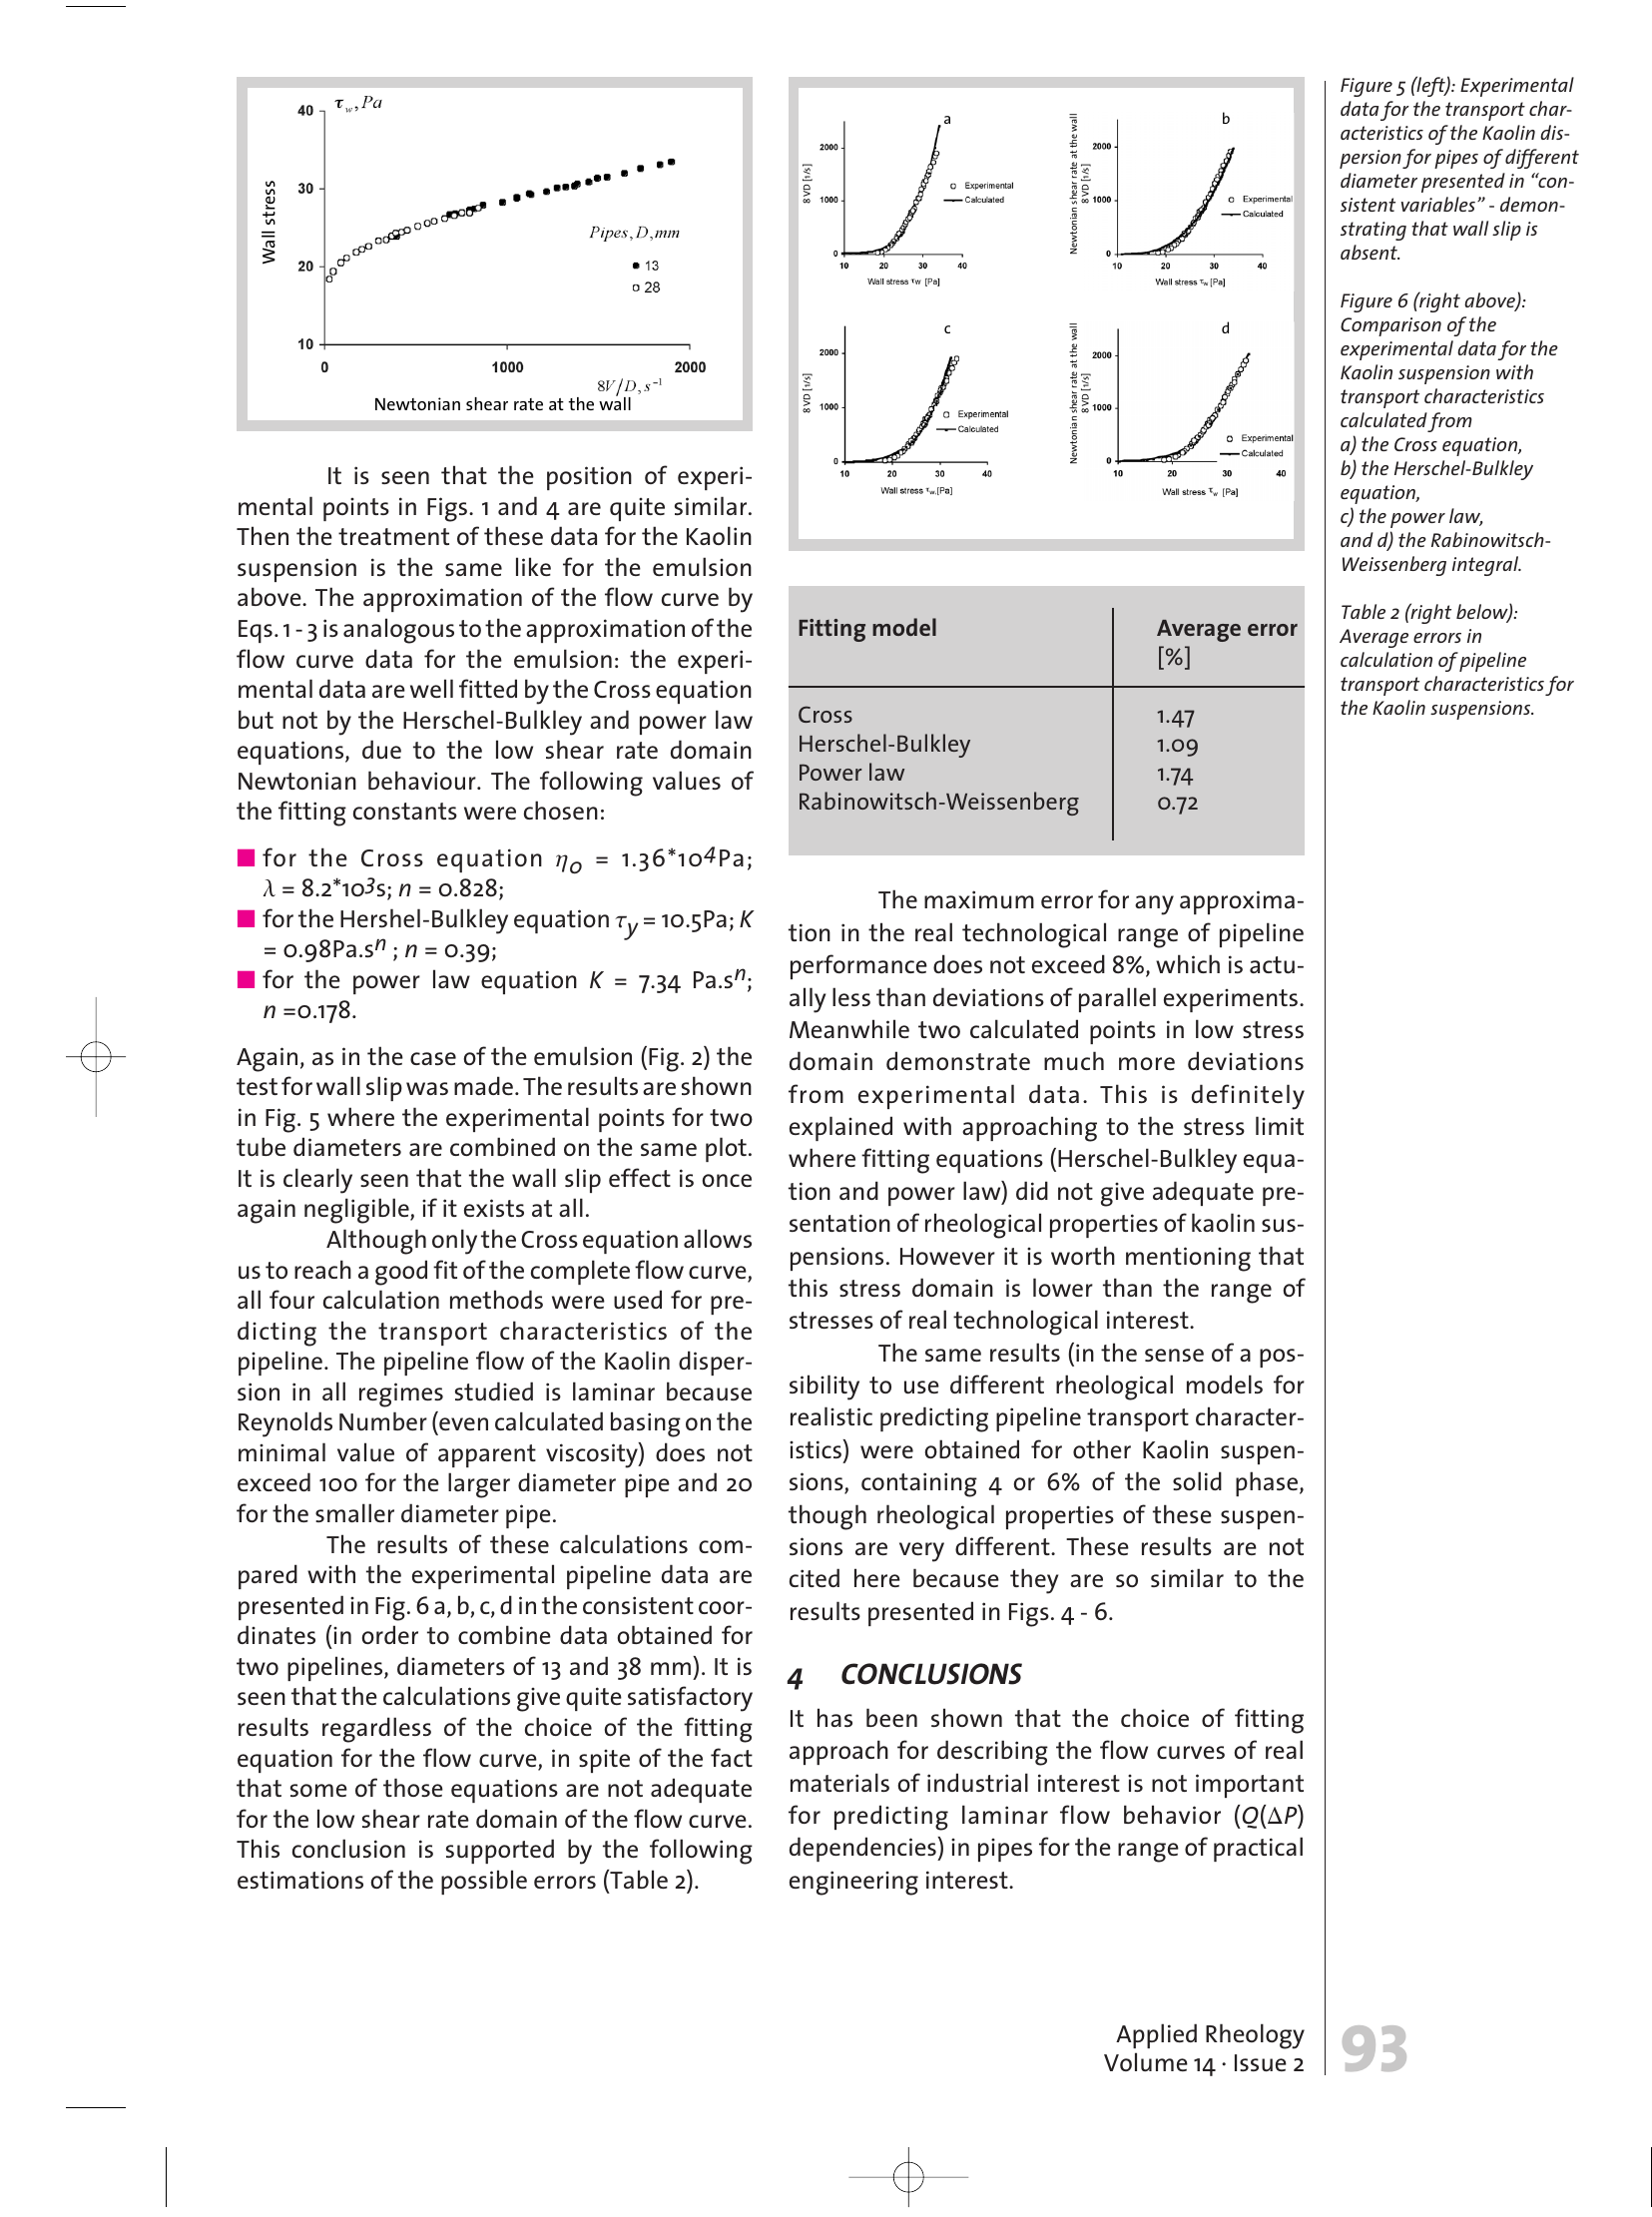
Figure 5 (left): Experimental data for the transport char- acteristics of the Kaolin dis- persion for pipes of different diameter presented in “con- sistent variables” - demon- strating that wall slip is absent. Figure 6 (right above): Comparison of the experimental data for the Kaolin suspension with transport characteristics calculated from a) the Cross equation, b) the Herschel-Bulkley equation, c) the power law, and d) the Rabinowitsch- Weissenberg integral. Table 2 (right below): Average errors in calculation of pipeline transport characteristics for the Kaolin